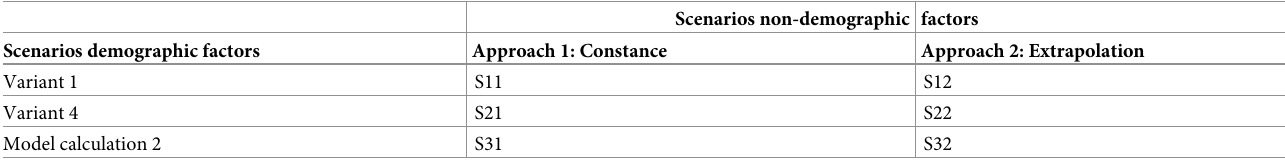
Table 3. Overview of the